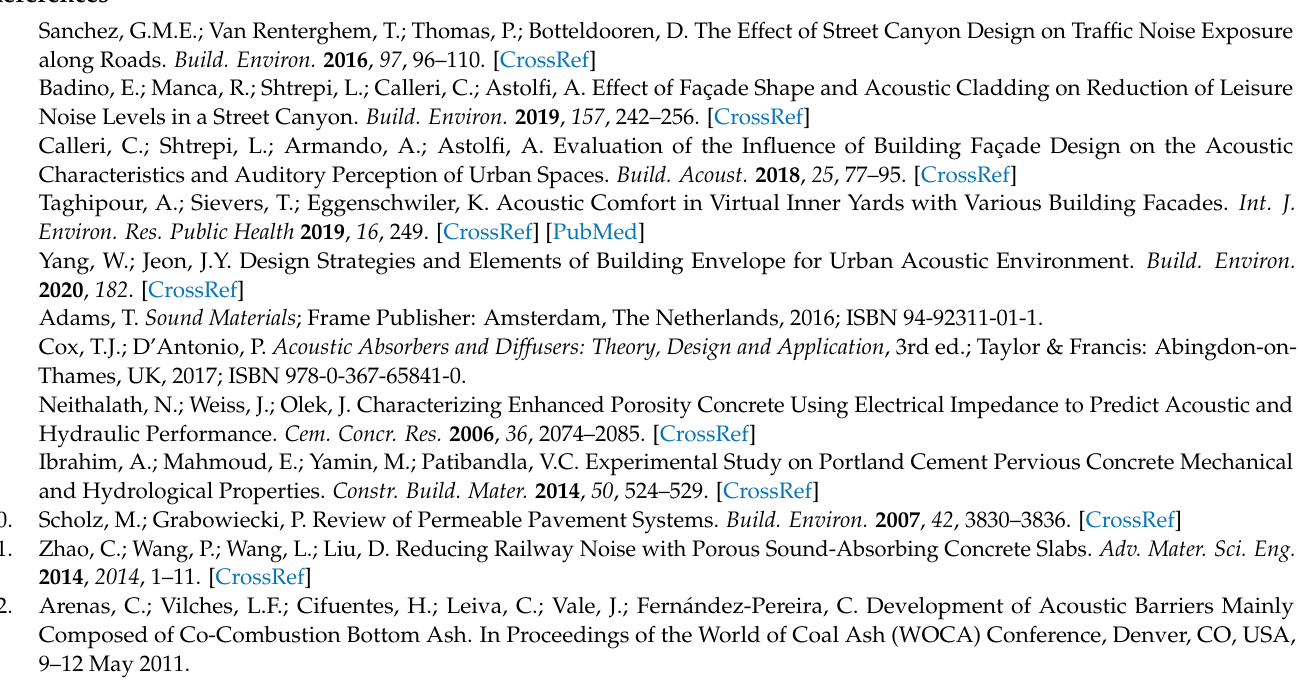
Figure A3. Comparison of the absorption coefficients for samples A–D with different thicknesses (20 and 40 mm) mounted over an airgap of 50 mm. Sample A: crushed normal weight aggregates 4–8 mm; Sample B: round lightweight aggregates 4–8 mm; Sample C: round lightweight aggregates 2–4 mm; Sample D: round lightweight aggregates 0.5–1